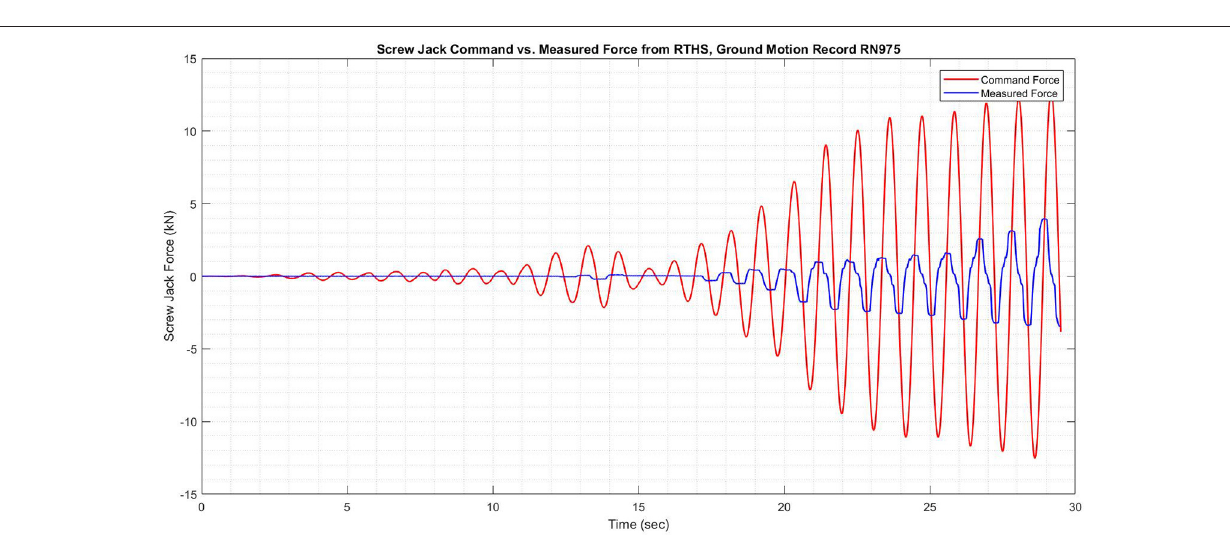
FIGURE 13 | Command screw jack force vs. measured force for record